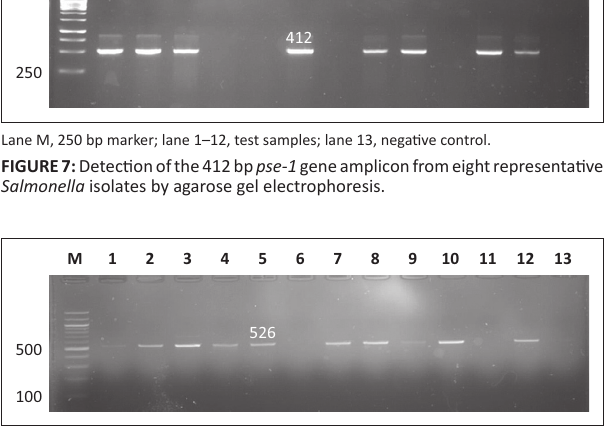
TABLE 6: Antibiotic resistance patterns of Salmonella isolates illustrating multiple drug resistance. Antibiotic resistance